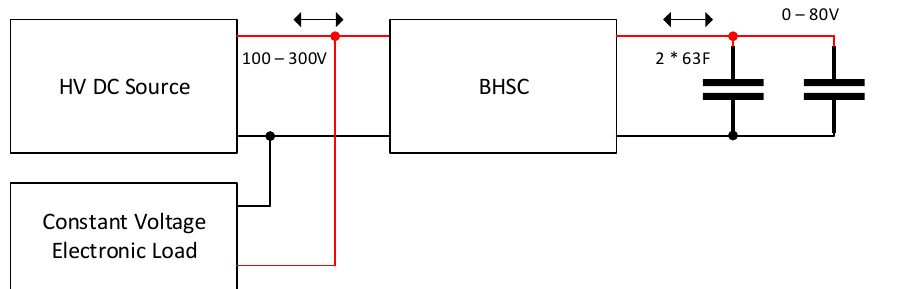
Figure 24. Experimental setup used for BHSC prototype testing.